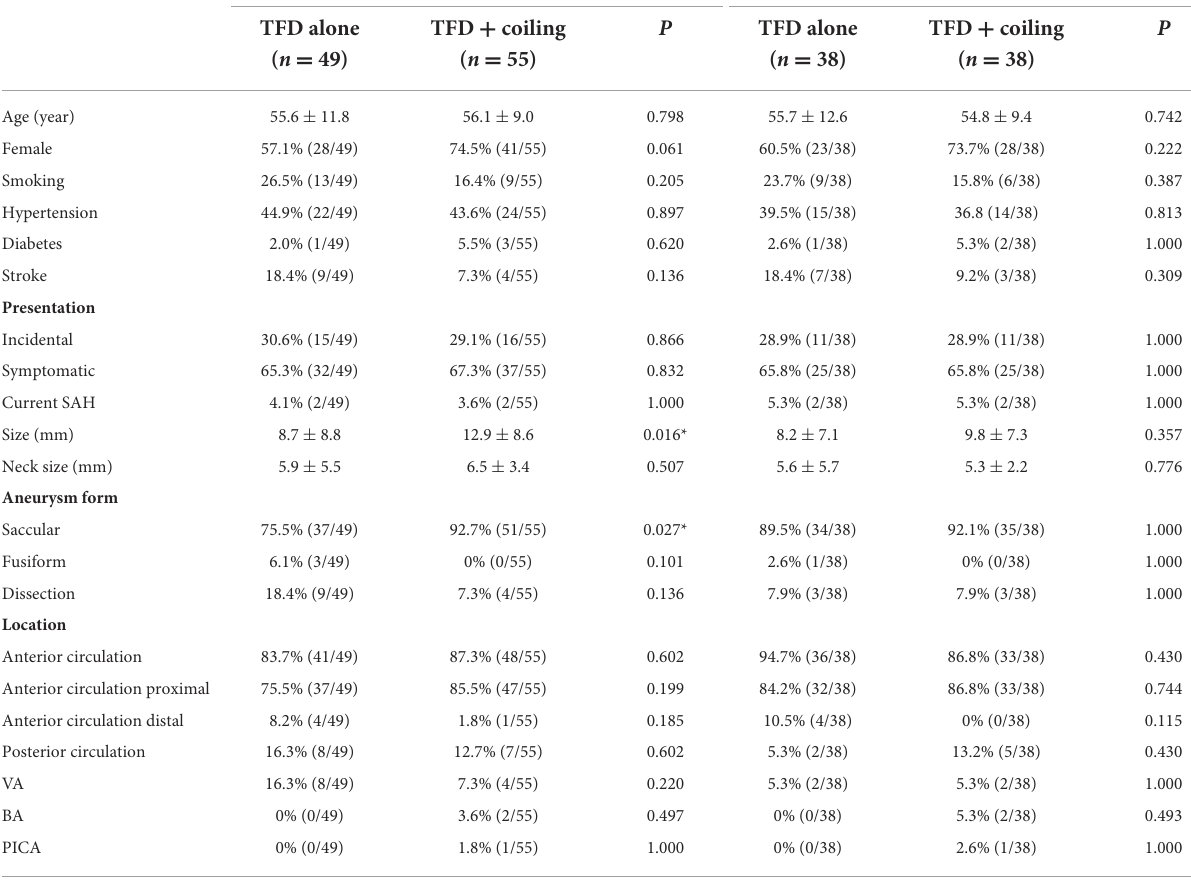
TABLE 1 Patients and aneurysm characteristics before and after propensity score matching. Before propensity score